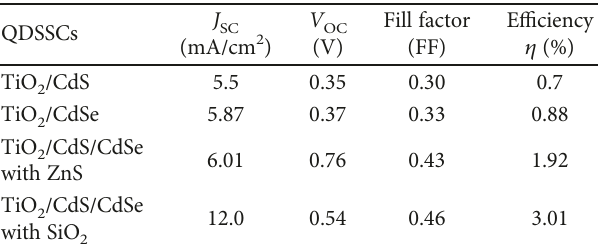
Table 2: The value parameters of di ff erent QDSSCs obtained from J - V curves.